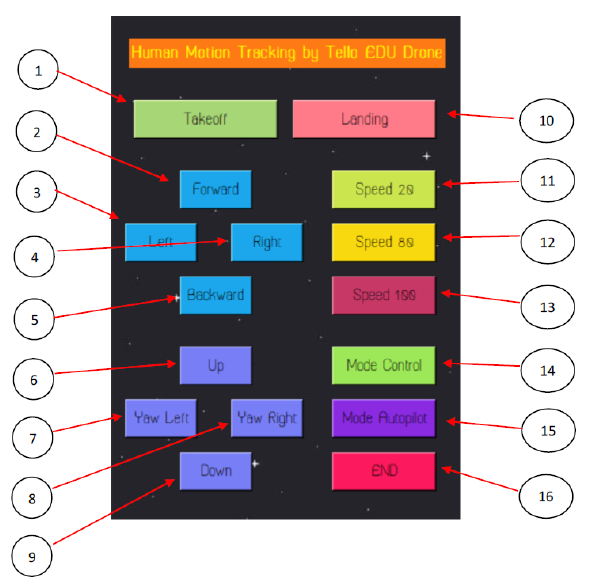
Figure 4. GUI design for direction, speed, manual, and automatic flight